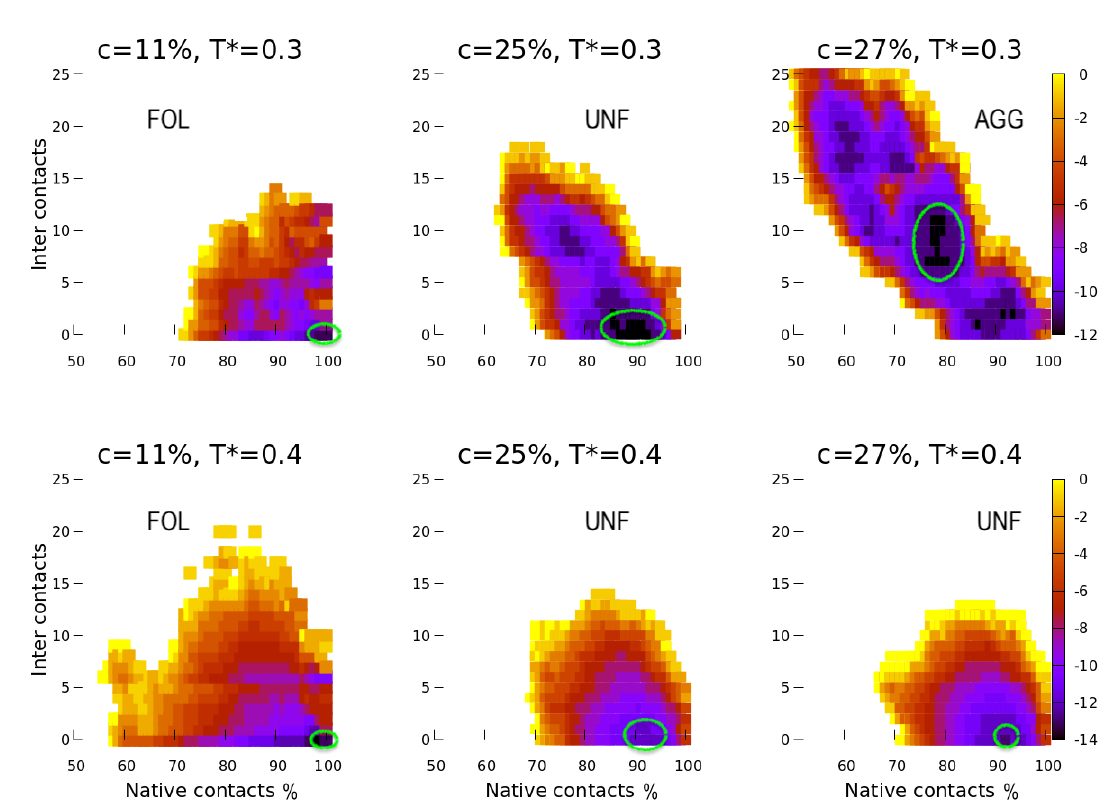
Figure 3. Color-coded free energy F as a function of the native contacts N c (horizontal axis, expressed as a percentage) and the average number of inter contacts 25 N p × I c (vertical axis), for different concentrations and temperatures. Darker colors correspond to deeper minima in free energy. We mark the absolute free-energy minima in green ellipses as guides for the eyes. We present data only for three concentrations. At ambient conditions (top panels) and c = 11%, the proteins are mainly folded (FOL). At c = 25%, they are unfolded (UNF) on average. At c = 27%, they are unfolded and aggregated (AGG) in their majority. At the warmer temperature (bottom panels), they tend to avoid aggregation, even if they unfold. Statistically, where the volume concentration is low (11%), the proteins explore a larger number of configurations than at higher density, given the high thermal energy and the larger available